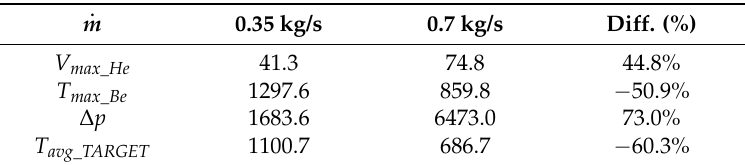
Table 6. Comparison of macroscopic flow fields parameter in the case of mass flow rate equal to 0.35 and 0.7 kg/s.